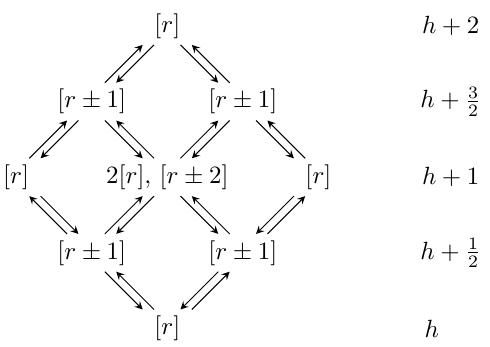
(cid:16) ¯ (cid:17) . In the figure only the SU(2) indices G b − 1 − 1 2 2